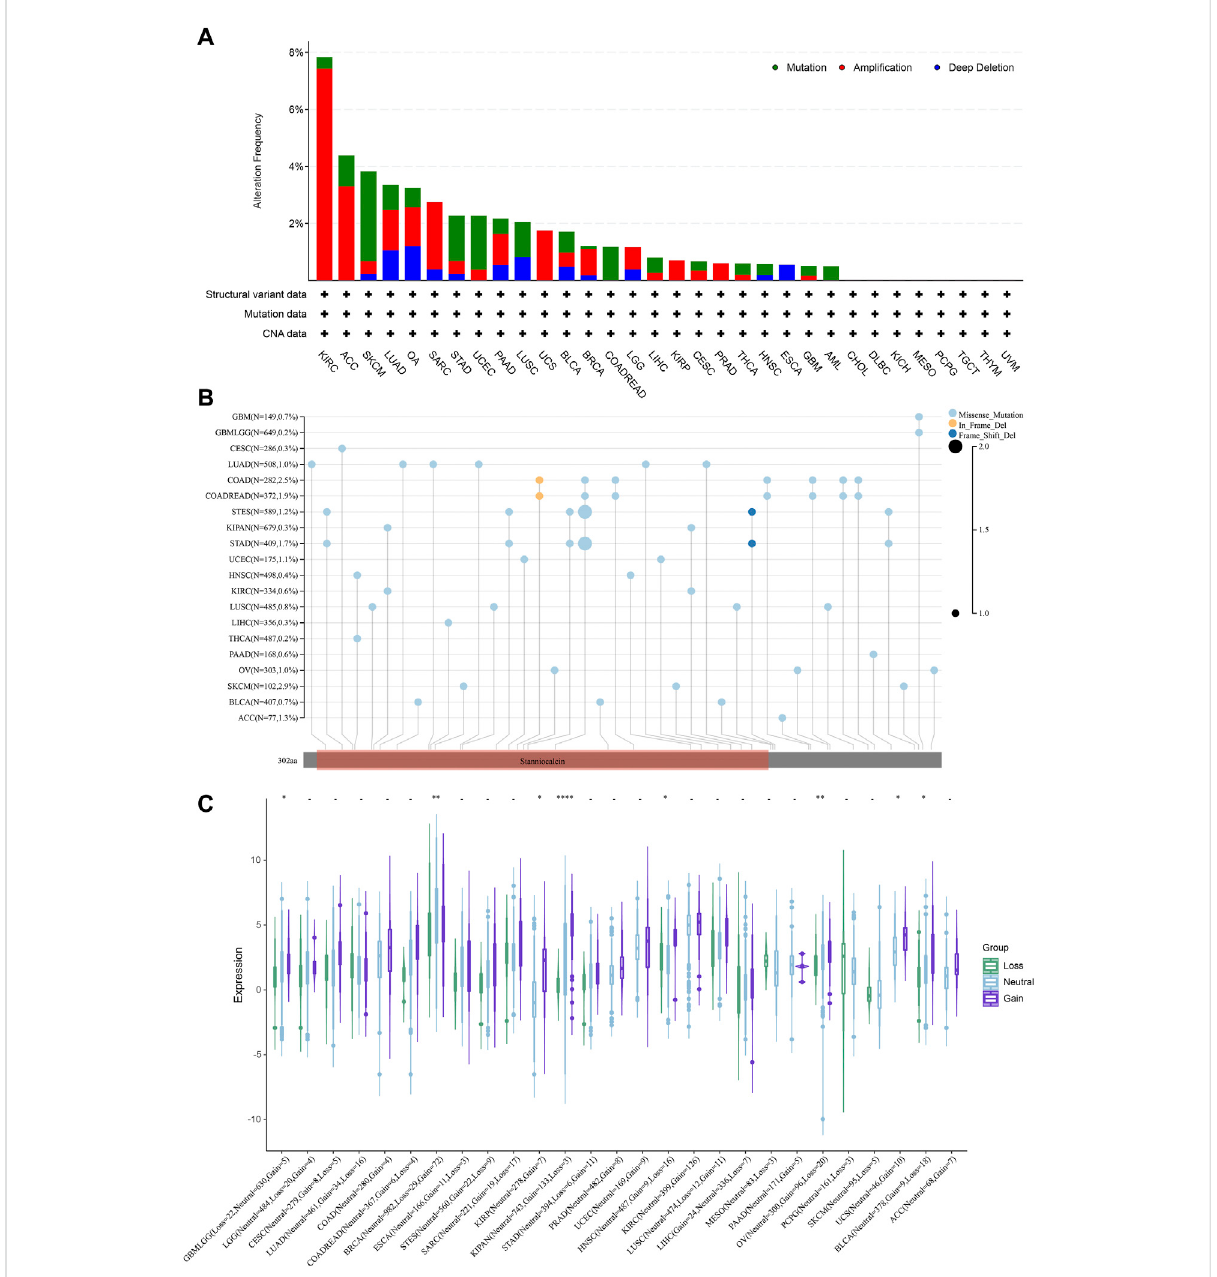
FIGURE 9 Mutation features of STC2. (A) Mutation features of STC2 in different tumor samples; (B) The types, sites and case percentage of STC2 genetic alteration; (C) The effects of copy number variation (CNV) on STC2 expression. *: p -value < 0.05; **: p -value < 0.01, ****: p -value <